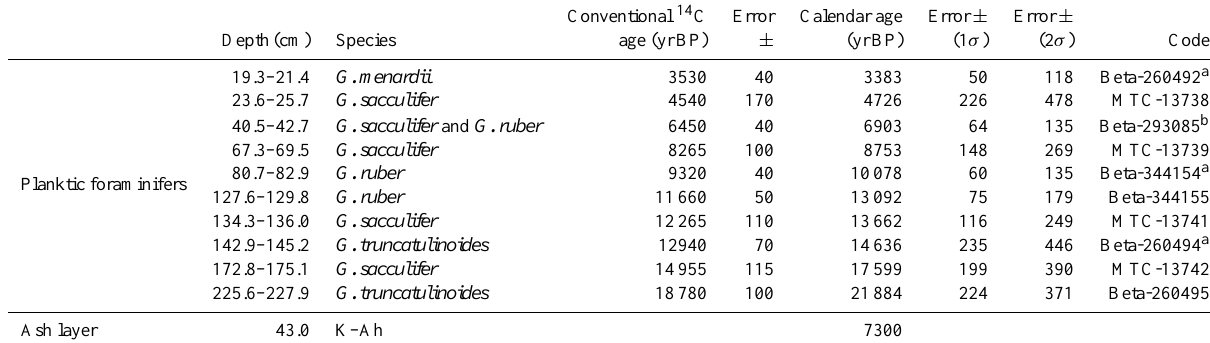
Table 2. Radiocarbon data from core GH08-2004.